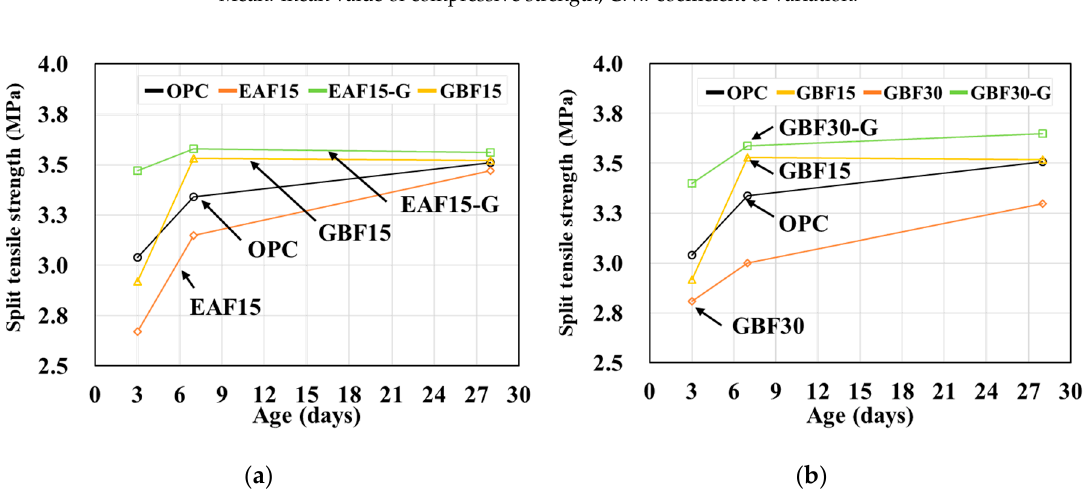
Table 6. Results of split-cylinder tensile strength.